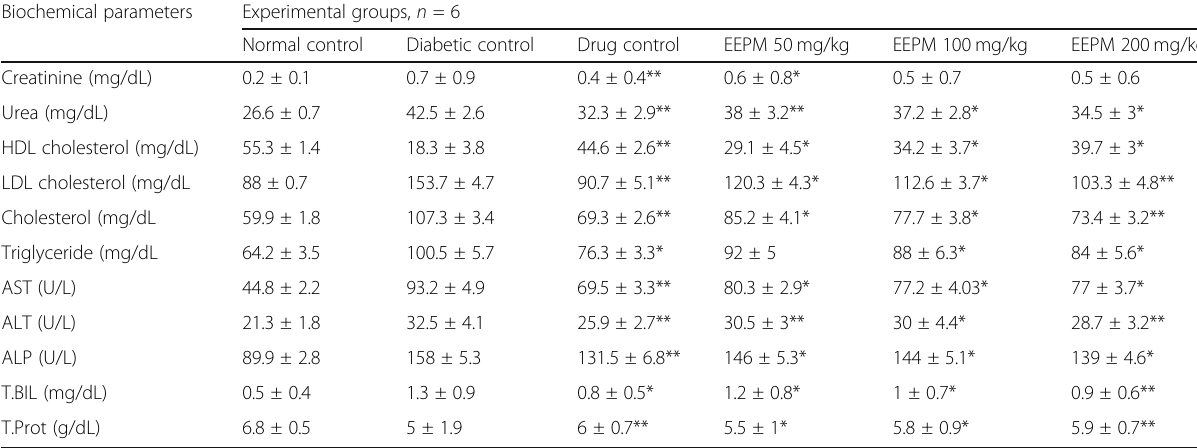
Table 5 Effects of repeated oral administration (35 days) of 50, 100, and 200 mg/kg EEPM fruits, normal control, diabetic